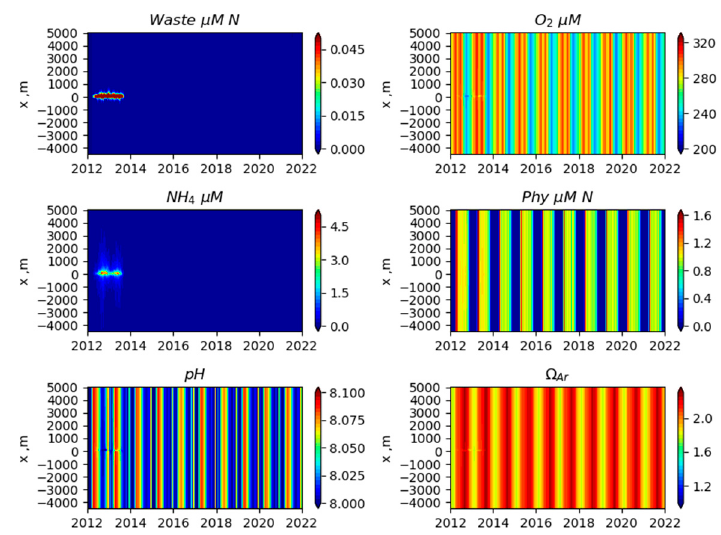
Figure 10. Modeled temporal variability of waste, oxygen (O 2 ), ammonium (NH 4 ), phytoplankton (Phy), pH and aragonite saturation ( Ω Ar ) at 10 m depth at a transect through the fish farm.